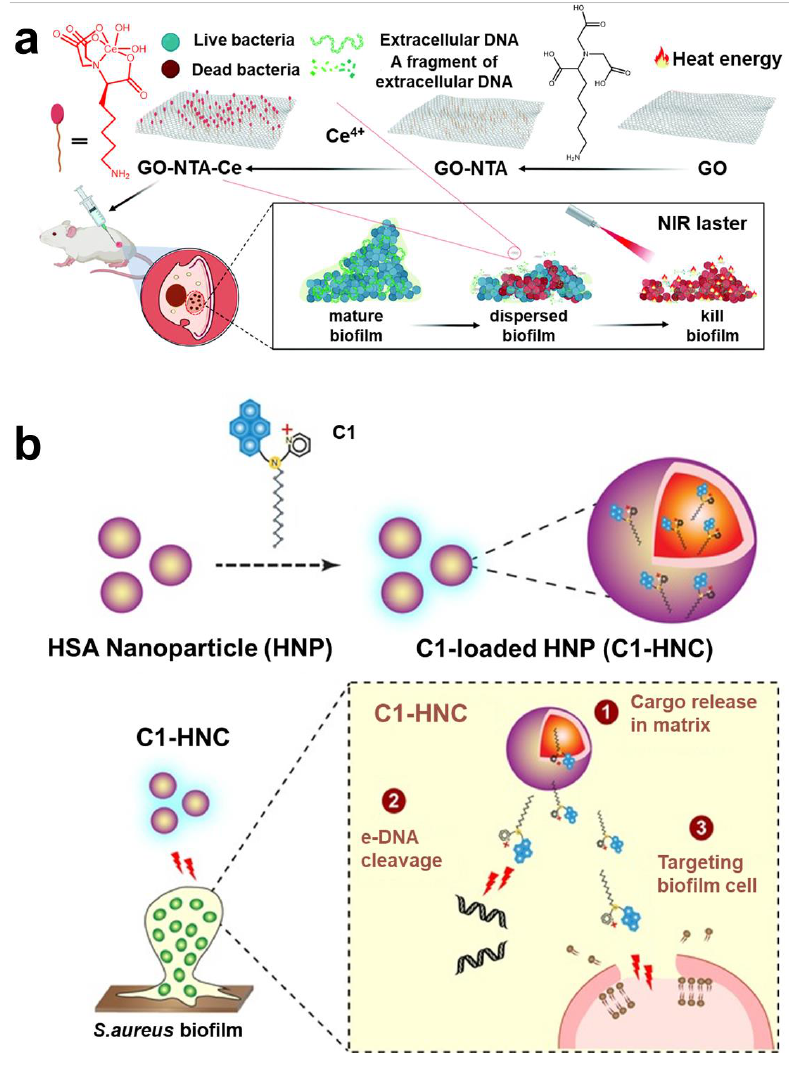
Figure 7. The eDNA targeting technology. ( a ) GO-NTA-Ce was used to target and destroy biofilm. Reprinted with permission from Ref. [150]. Copyright 2022, Haiwei Ji. ( b ) Amphiphilic compound C1 with eDNA and membrane-targeting function, assembled with HNP into nanoparticles for targeting and destroying S. aureus biofilm. Reprinted with permission from Ref. [153]. Copyright 2016,